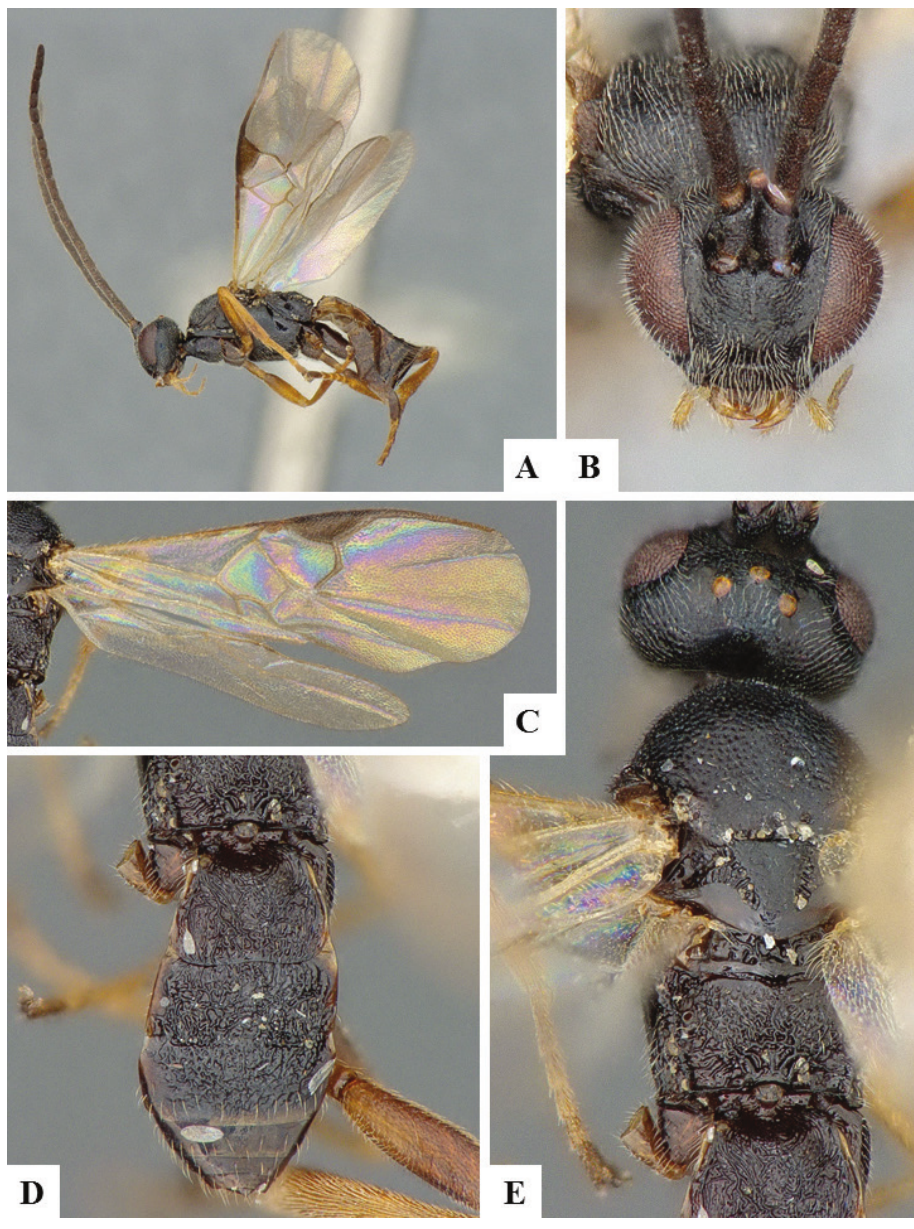
Figure 33. Pholetesor rhygoplitoides. A Habitus, lateral B Head, frontal C Wings D Metasoma, dorsal E Head and mesosoma,